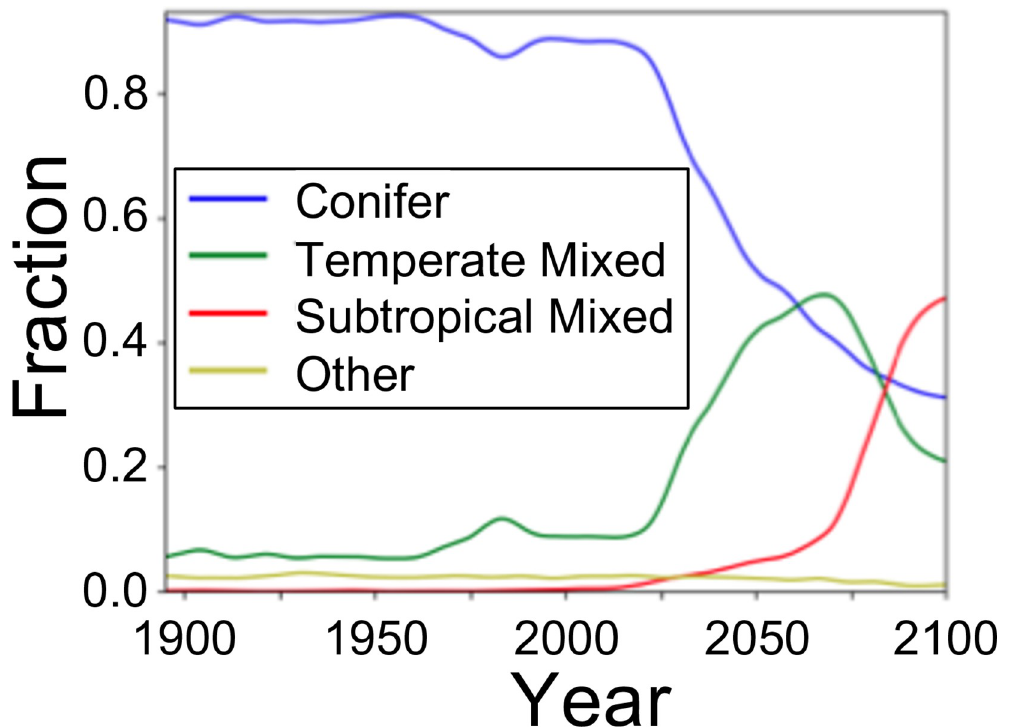
Fig 10. Vegetation class mix over time for FF-WCE (full fire with CO 2 fertilization) scenario. All other scenarios yield virtually identical